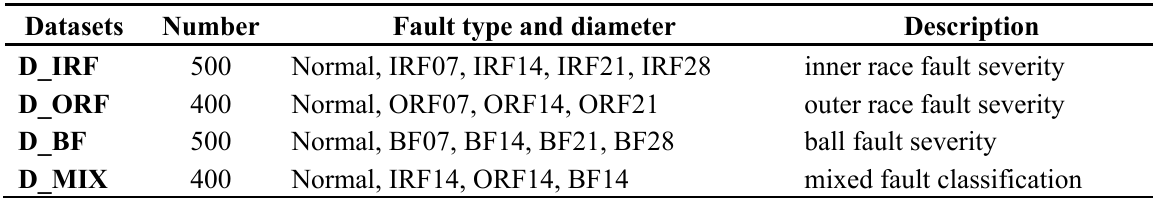
Table 2. The experimental datasets.